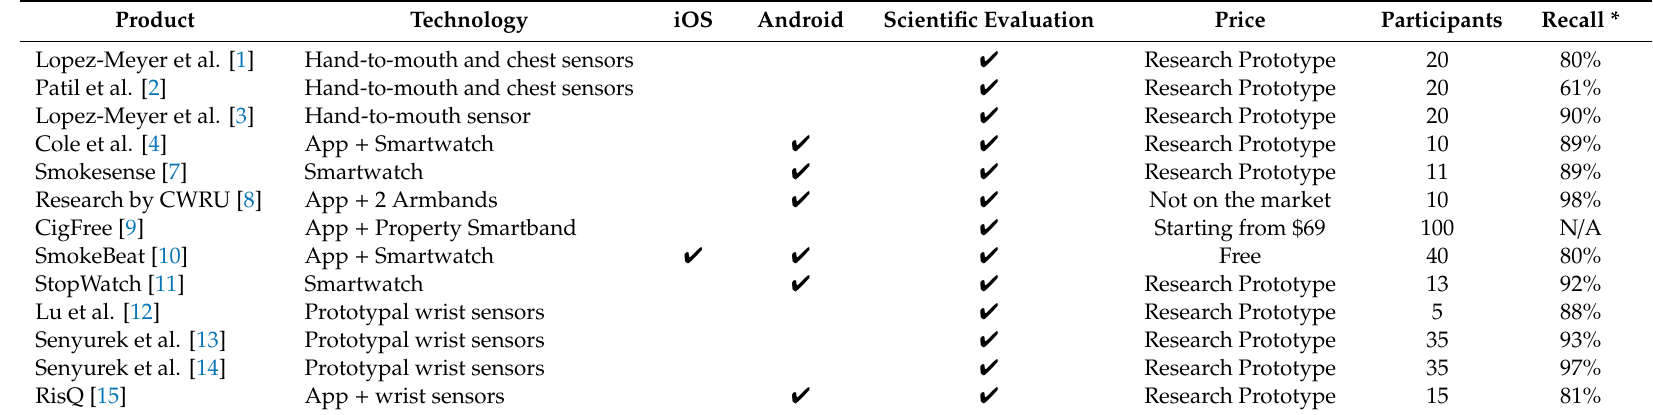
Table 1. Summary of the smoking detection technologies described in this